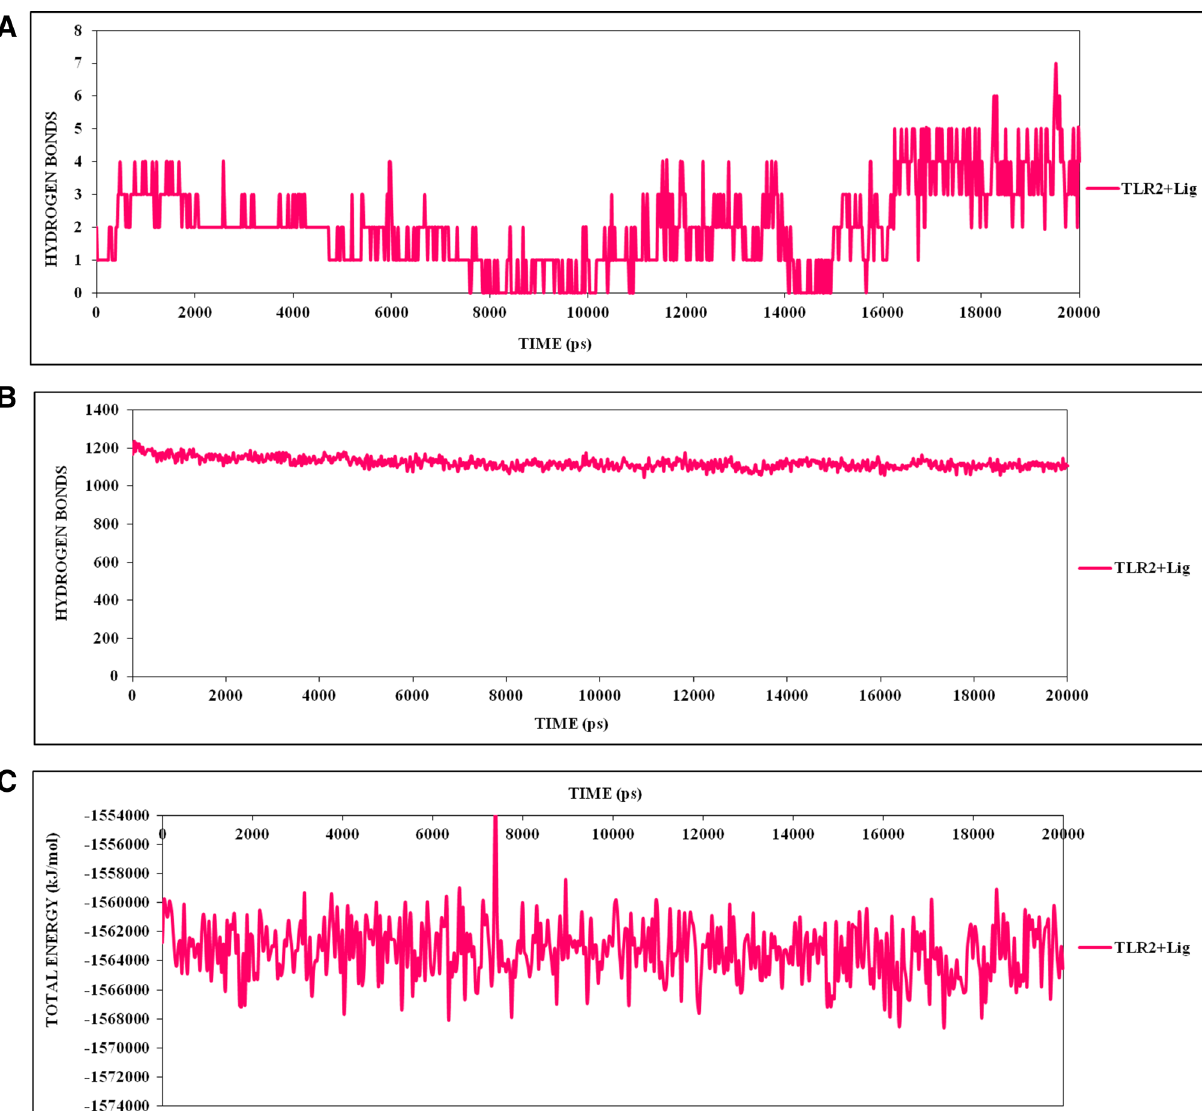
Figure 4. ( A ) The statics of consistent high number of hydrogen bonds involved in strong binding of CTL epitope to TLR2 receptor. ( B ) Depiction of TLR2 receptor-CTL epitope stabilized hydrogen bond throughout the simulation run. ( C ) The binding energies calculation of CTL epitope to TLR2 receptor, which showing the stringent interaction in all cluster frames in 20 ns